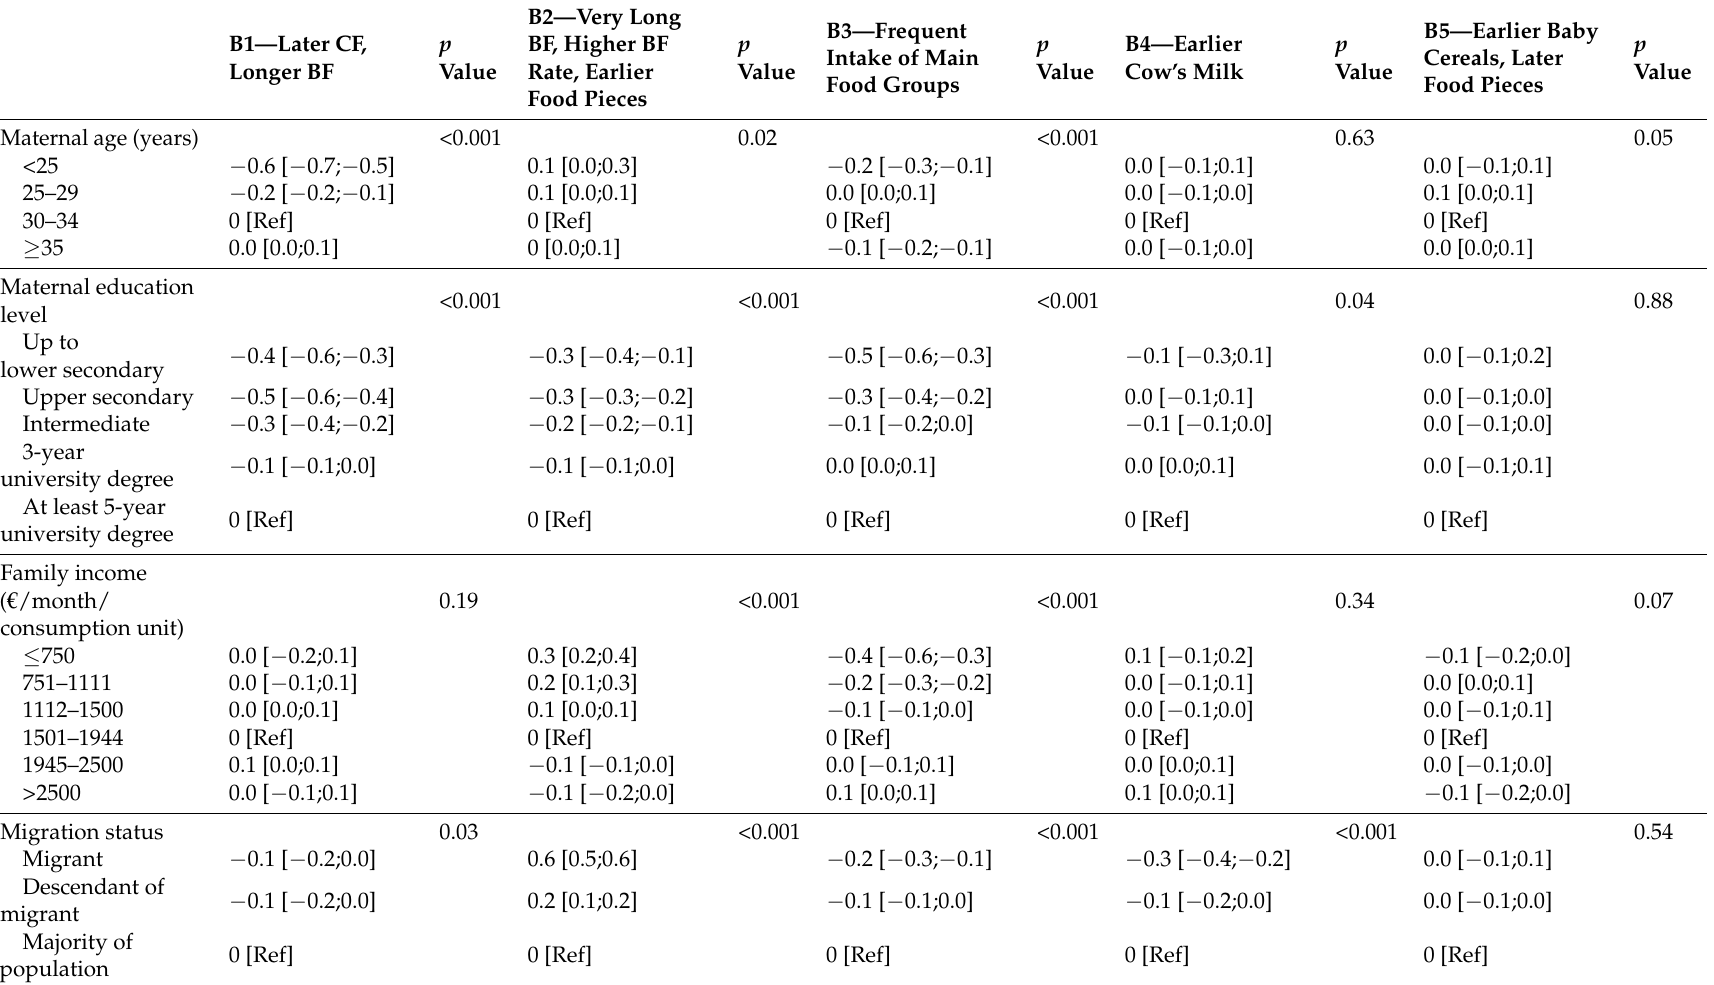
Table 4. Multivariable linear regression analysis explaining each pattern (identified by principal component analysis (PCA)) by family characteristics ( n =